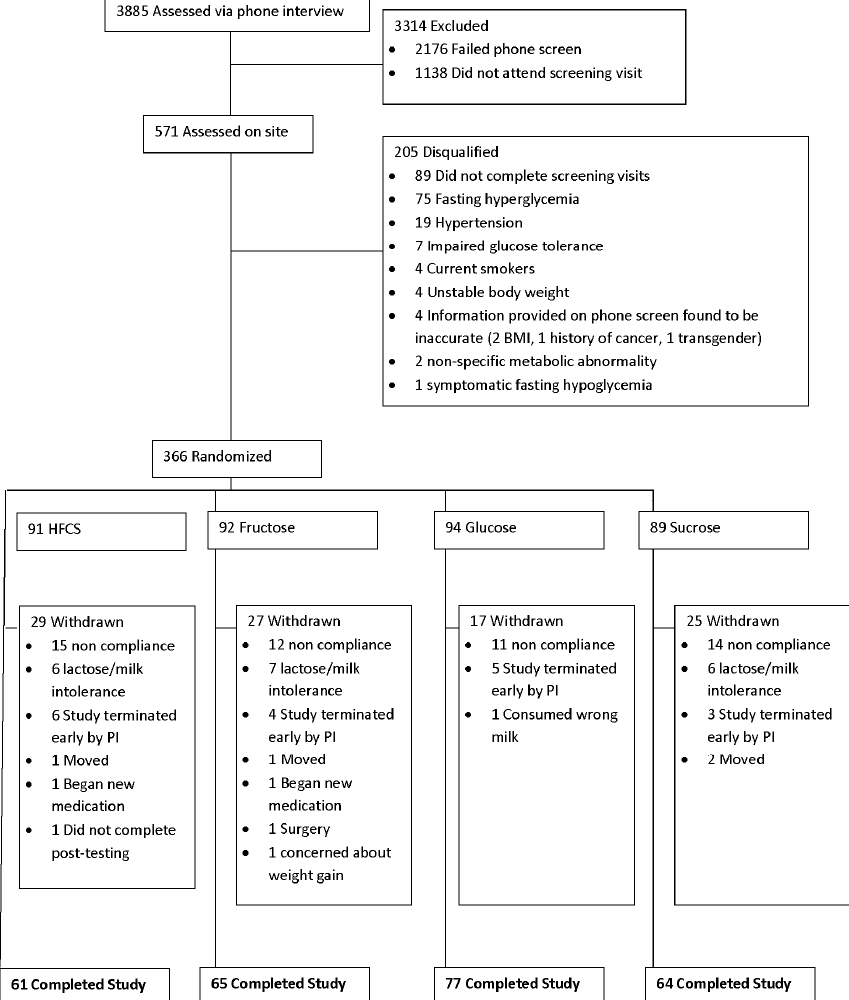
Figure 1. Participant flow over the course of the ten ‐ week trial: 366 participants were randomly assigned to one of four groups, each required to consumed a low ‐ fat, sugar ‐ sweetened milk in an amount that the added sugar contributed 9% (fructose and glucose) or 18% (sucrose and high fructose corn syrup (HFCS)) of the daily energy intake required for weight